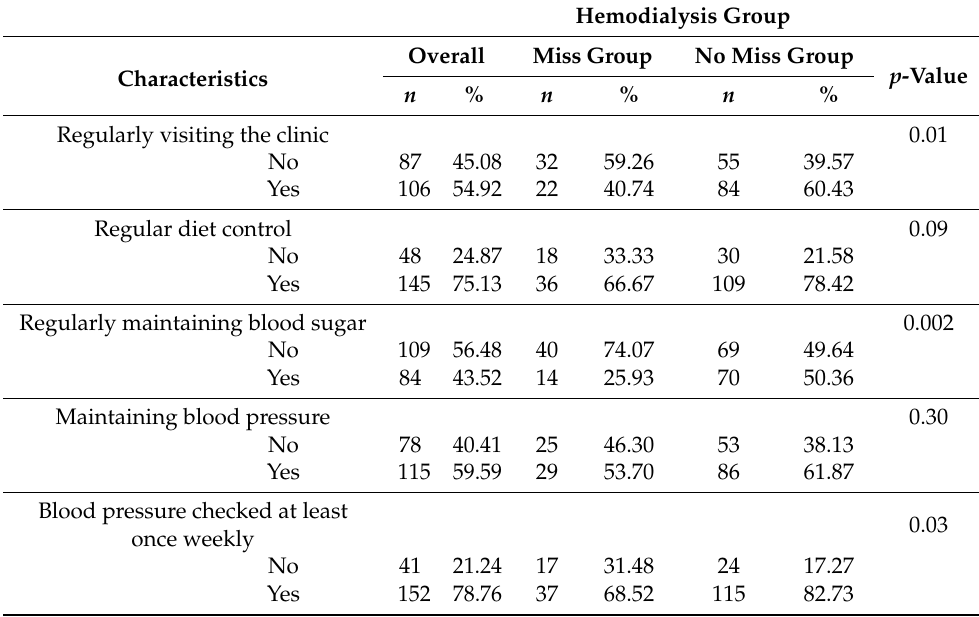
Table 3. Self-care behaviors among the study